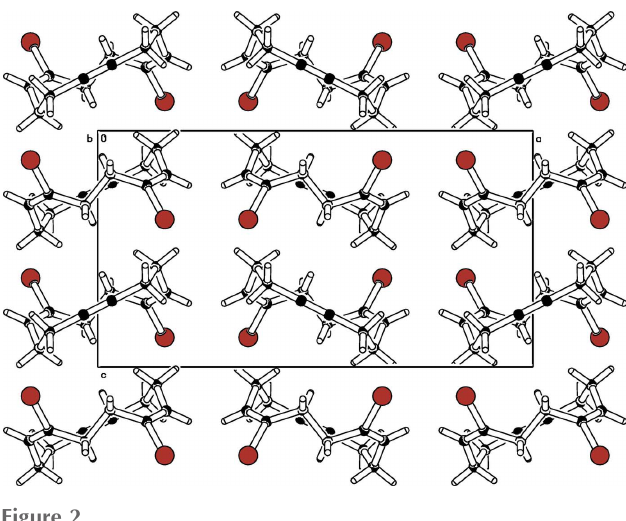
Figure 2 Part of the packing diagram. View along b -axis